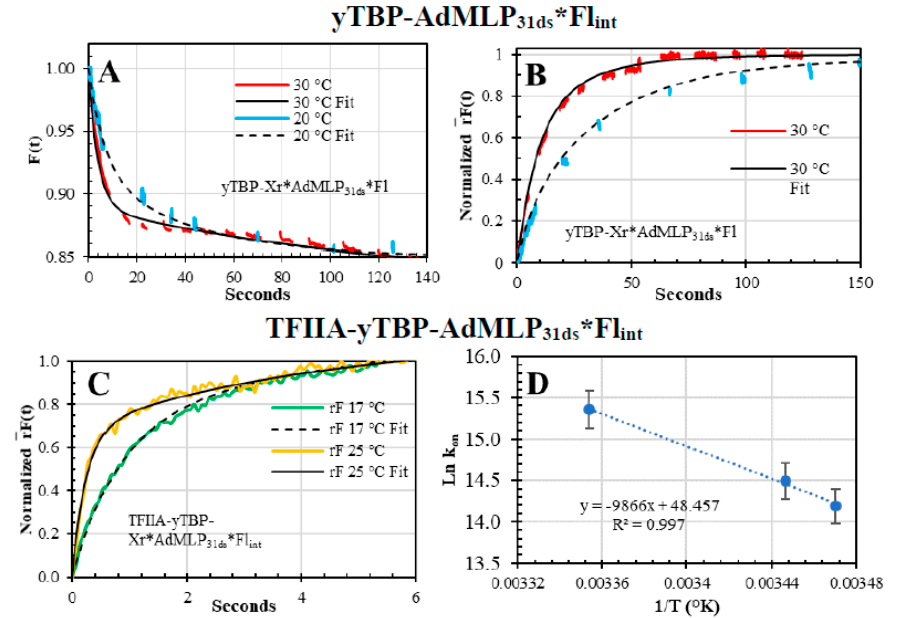
Figure 11. Association kinetic of binary yTBP-AdMLP 31ds *Fl int and ternary complex TFIIA-yTBP- AdMLP 31ds *Fl int . ( A ) The association traces of yTBP (220 nM) and AdMLP 31ds *Fl int (20 nM), at 20 ° C (blue) and 30 ° C (red), were monitored by the F(t) sensing modality, yielding parameters of α 1 = 8.0% ( ± 1.0%), λ 1 = 0.15 s − 1 ( ± 0.010 s − 1 ), α 2 = 7.0% ( ± 1.0%), λ 2 = 0.025 s − 1 ( ± 0.010 s − 1 ), baseline = 85.0% ± 2.0%; and α 1 = 9.8% ( ± 0.3%), λ 1 = 0.26 s − 1 ( ± 0.03 s − 1 ), α 2 = 5.2% ( ± 0.3%), λ 2 = 0.0085 s − 1 ( ± 0.0015 s − 1 ), baseline = 85.0% ± 2.0%, respectively. ( B ) The 𝑟𝐹(cid:3364)(cid:3364)(cid:3364)(𝑡) association traces of binary yTBP (220 nM)-AdMLP 31ds *Fl int